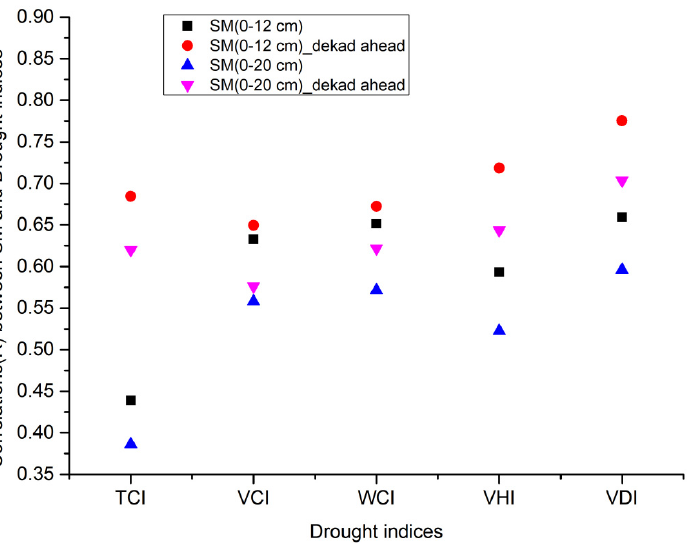
Figure 10. The R values for the TCI, VCI, WCI, VHI, VDI and field soil moisture at depths of 12 and 20 cm.